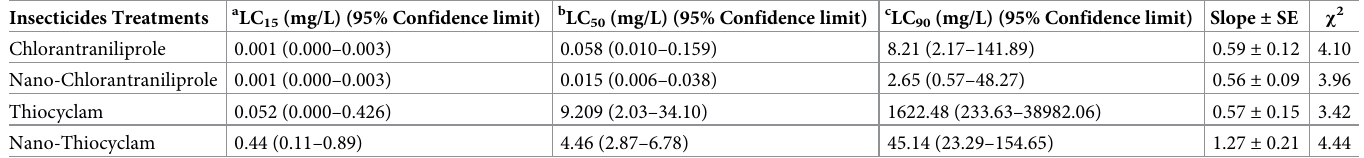
Table 2. Lethal and sublethal activity of chlorantraniliprole, thiocyclam, and their nano-form in the 2 nd instar larvae of Agrotis ipsilon .